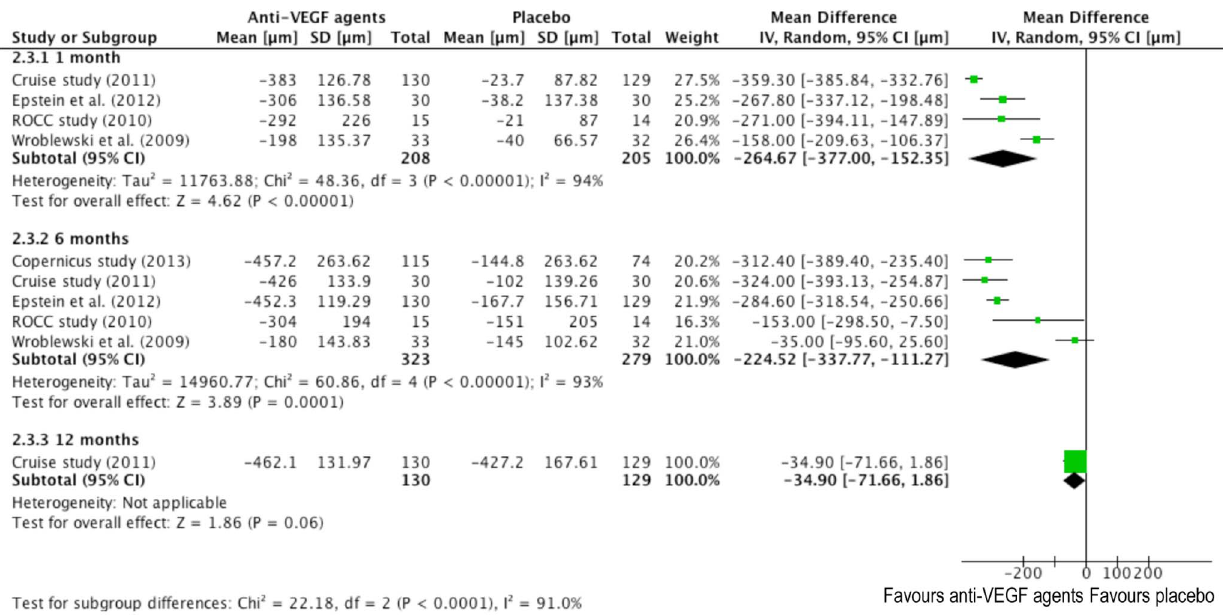
Figure 5. Forrest plots for the mean change in central retinal thickness ( m m) at one, six and twelve months between anti-VEGF and placebo group.